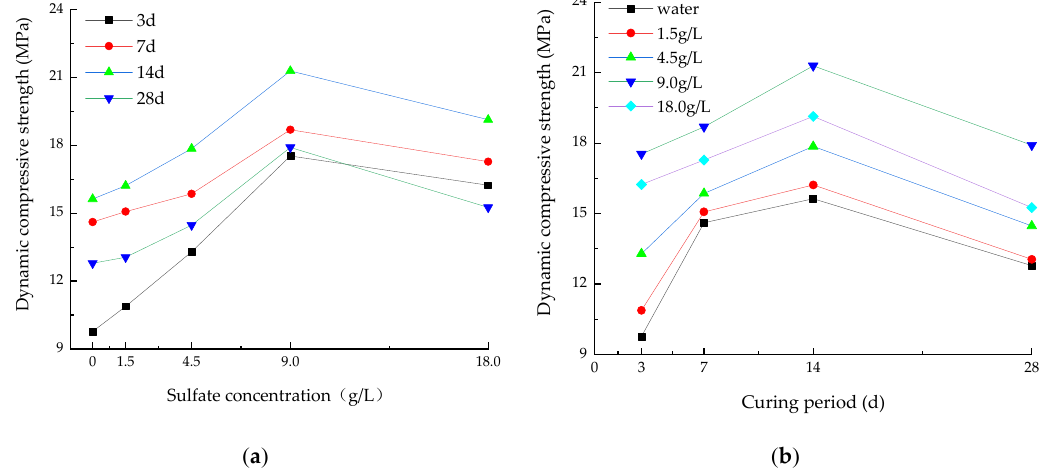
Figure 7. Relationships between dynamic compressive strength, sulfate concentration, and curing period: ( a ) different sulfate concentrations and ( b ) different curing periods.